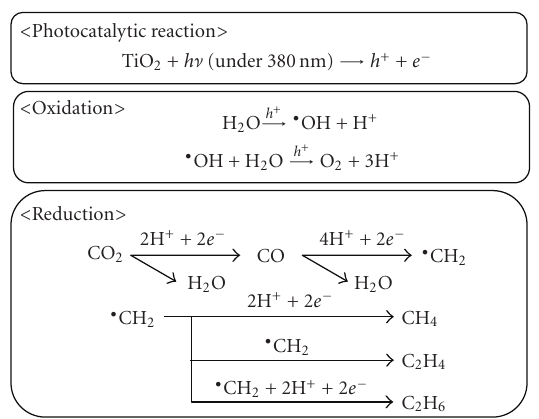
Figure 7: Reaction scheme of CO 2 reforming into fuel by TiO 2 photocatalyst ( · OH: hydroxy radical, · CH 2 : carben radical).